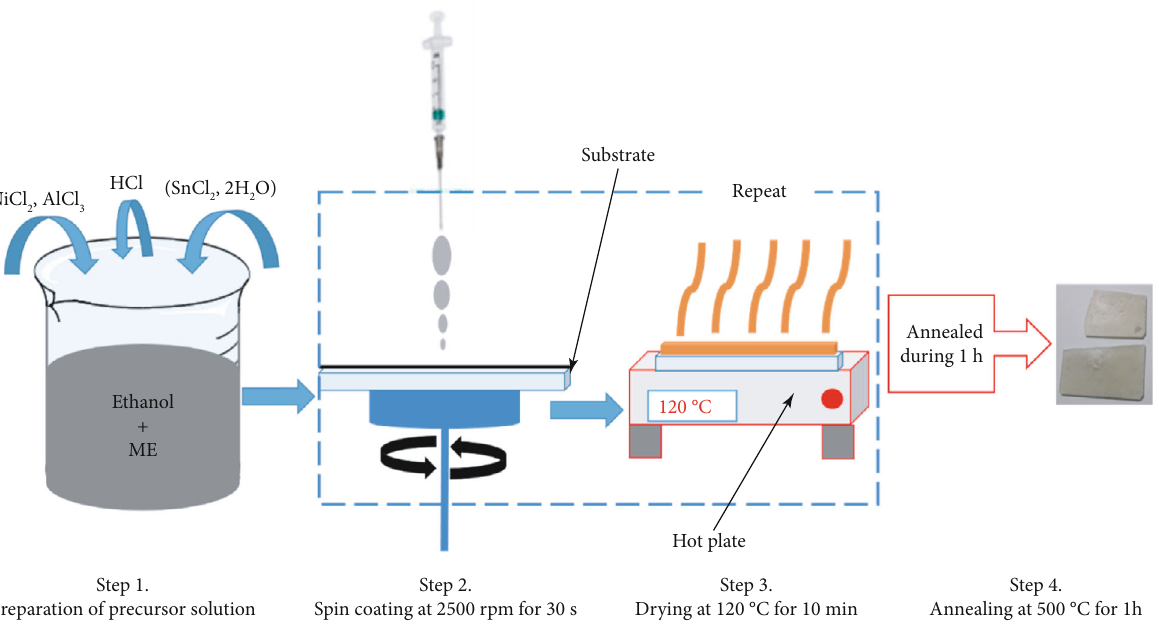
Figure 1: Schematic presentation of the experimental procedure of sol – gel spin coating.